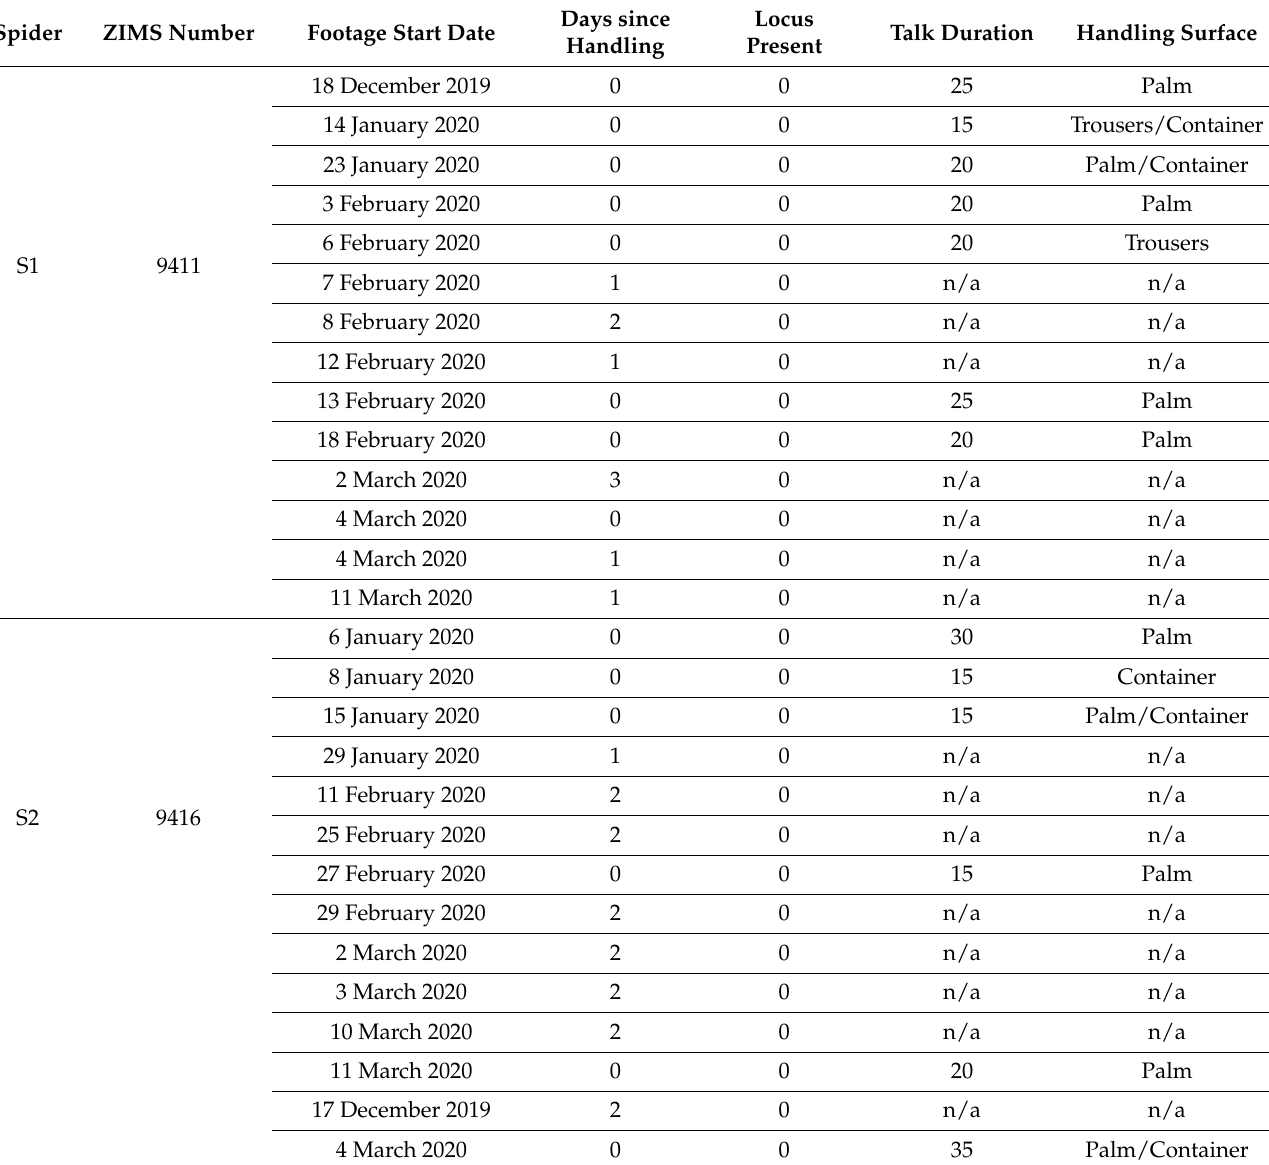
Table A1. Footage start dates, spider Zoological Information Management System (ZIMS) numbers, days since handling, locust presence, talk duration and handling surface for each handling